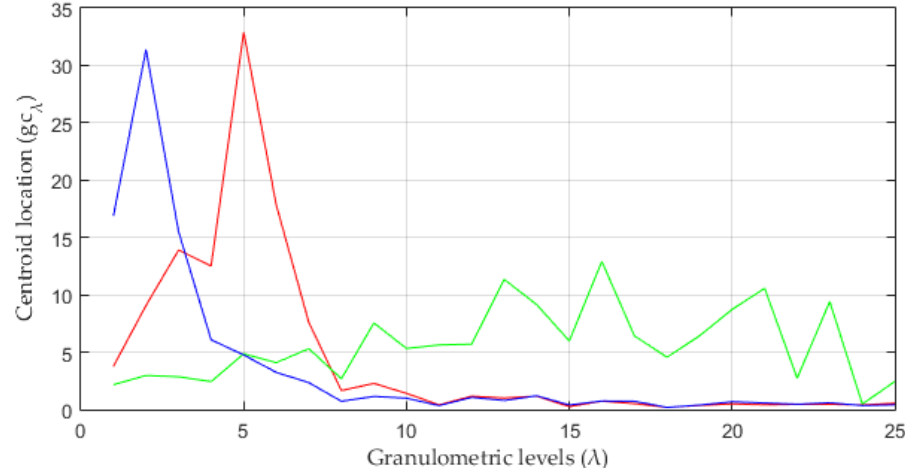
Figure 16. Granulometric profiles of 3 classes from 12 granulometric levels. Kirib Kaina, 2010 .